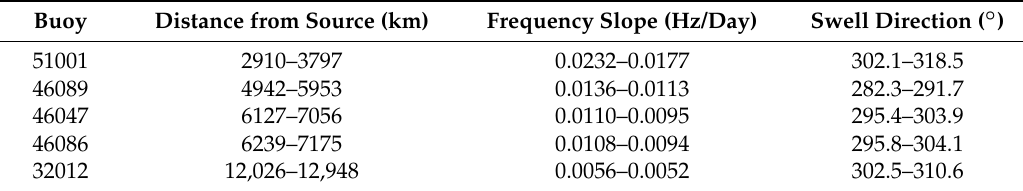
Table 2. EnKF parameters for the control